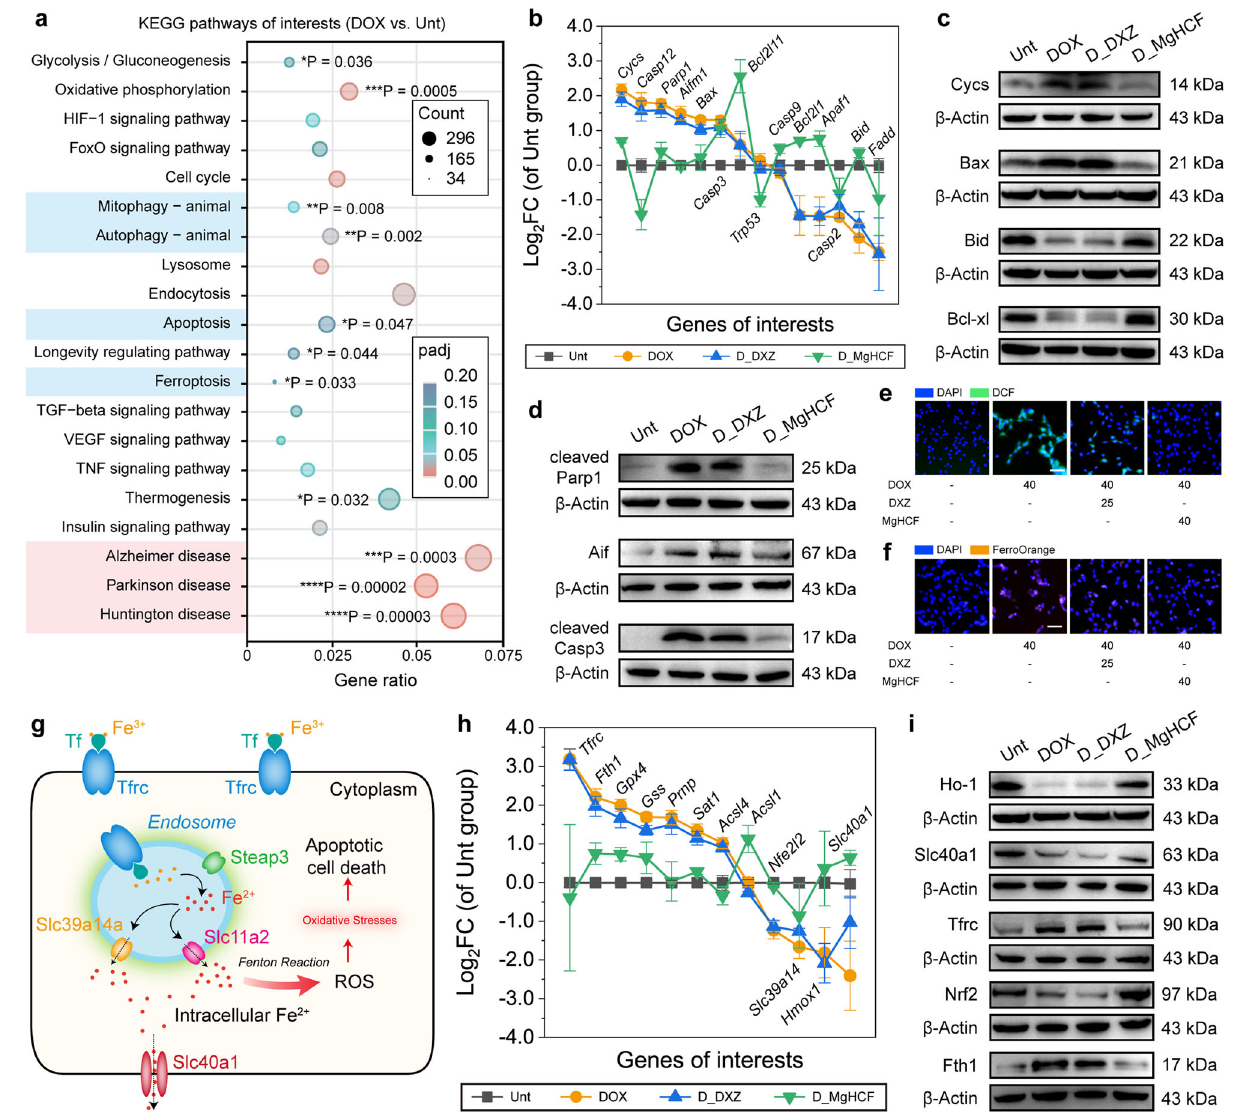
Fig. 5 | In vitro therapeutic mechanism exploration of cardiac protection. a KEGG enrichment pathway for DOX-treated cells as compared to the untreated cells. Signi fi cant tests (padj) are based on the negative binomial distribution with further corrections (Benjamini – Hochberg procedure). * P <0.05, ** P <0.01, *** P <0.001 and **** P <0.0001. b Distributions of the cell-apoptosis-associated genes in different groups. n =3. Data are presented as mean±s.d. c and d Protein expressions of Cycs, Bax, Bcl-xl ( c ), cleaved-Parp1, Aif and cleaved-caspase-3 ( d )